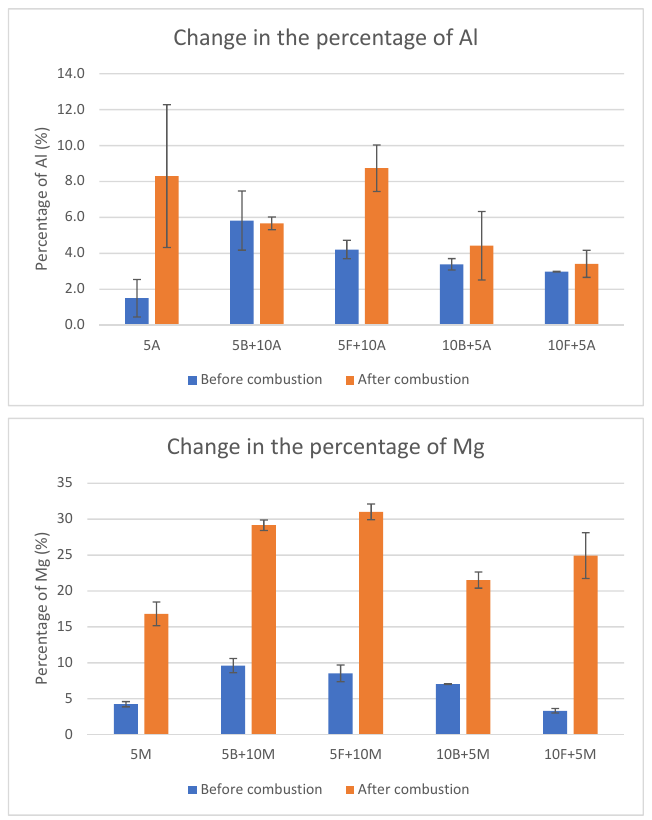
Figure 3. Change in percentual contents of Al and Mg before and after combustion .